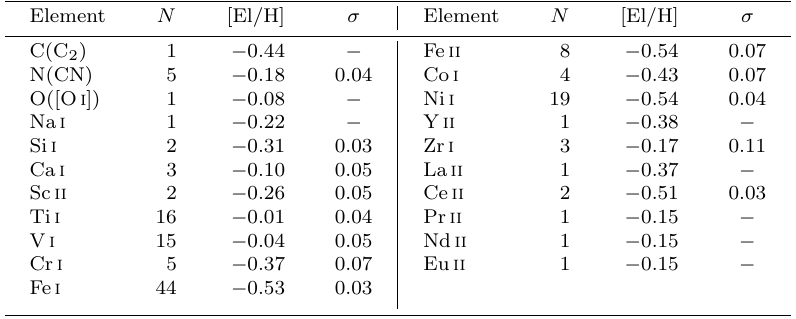
Table 3. Element abundances relative to hydrogen [A/H]. (cid:27) is a standard deviation in the mean value determined from the line-to-line scatter within the species. N is the number of lines used for the abundance